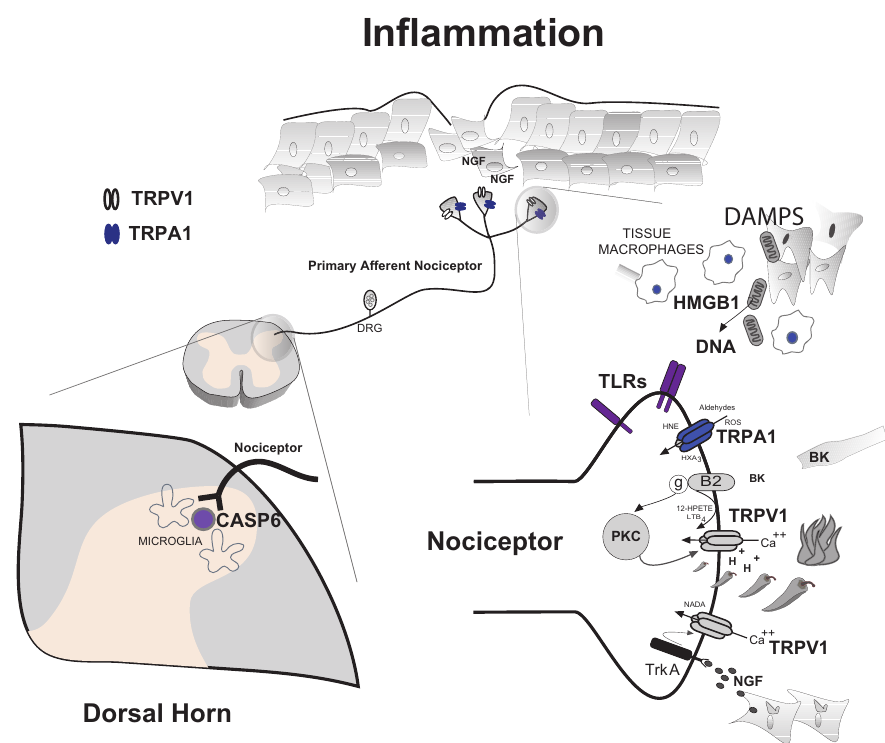
Figure 1. Inflammatory Pain. Tissue injury evokes a complex series of cellular responses that together is proposed to drive painful hyperalgesic states . Specialized primary afferent nociceptors (top center) innervate tissues and signal potential or actual cellular injury through detection of noxious chemical, thermal and mechanical stimuli. Electrochemical transduction of noxious stimuli at nociceptor terminals include activation of transient receptor potential (TRP) ion channel family members. As a result of the synthesis and/or release of injury – induced inflammatory products, nociceptor transducing elements may be positively modulated or directly activated driving painful and hyperalgesic states. A number of these products (eg: peptides [BK], activation of PKC, TrkA activation by NGF, acid [H + ], lipoxygenase products - 12-HPETE, LTB , NADA, as well as reactive oxygen species [ROS], aldehydes, HNE and HXA ) have been shown to either modulate or activate TRPV1 4 3 and TRPA1 respectively (bottom right). Certain products of inflammation (eg: nerve growth factor [NGF], ROS, aldehydes) modulate multiple pain transducing receptors/elements. Depending on the mechanism and severity of tissue injury, innate immune cell responses will be recruited. Damage-associated molecular patterns (DAMPs) such as HMGB1 and mitochondrial derived DNA bind and activate toll-like receptors (TLRs) expressed on nociceptor terminals further driving hyperalgesia. Monocyte derived macrophages invade injured tissue and release a complex array of cytokines, chemokines and growth factors such as NGF. Together, they conspire to transform nociceptor phenotype to pathophysiologic states of persistent nociceptor activation, lowered firing thresholds and/or exaggerated response properties. Tissue inflammation also influences the central processing of nociceptive input in the dorsal horn of the spinal cord (bottom left). As a result, central nociceptor terminals upregulate and release signaling molecules such as CASP6 that activates microglia – dependent inflammatory